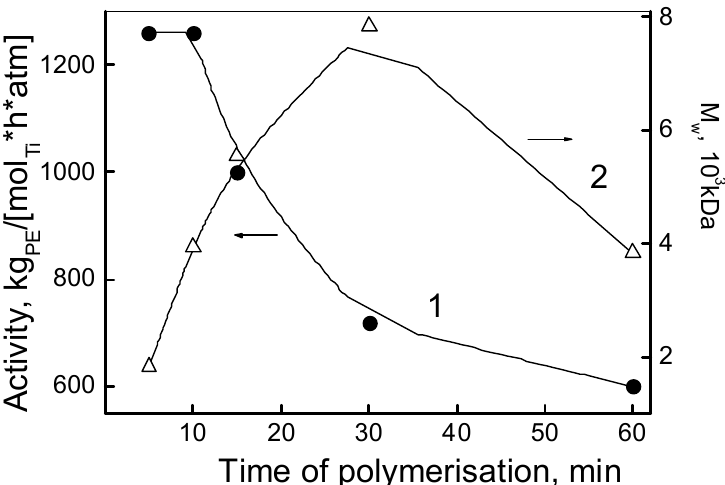
Figure 2. Catalytic activity (1) of the system I and molecular weight of the obtained ultrahigh molecular weight polyethylene (UHMWPE) samples (2) versus the polymerization time.